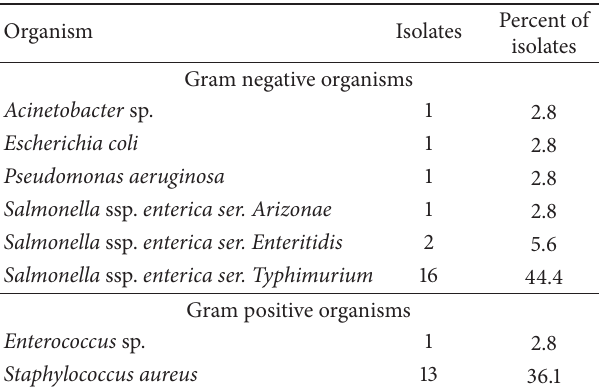
Table 1: Bacterial isolate